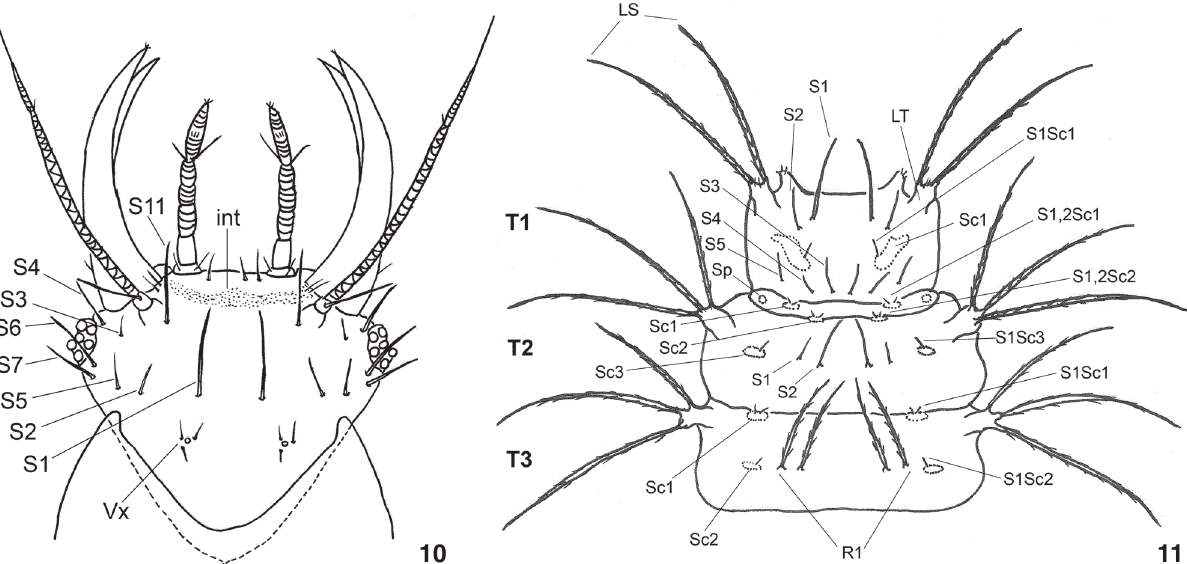
Figuras 10-11. Primeiro instar de C. caligata : (10) cabeça, vista dorsal; (11) tórax, vista dorsal. (int) Mancha intermandibular, (Sx) cerda primária, (Vx) três pequenas cerdas posteriores ao redor de um poro, (LS) cerda no tubérculo lateral, (LT) tubérculo lateral, (R1) fileira de cerdas, (Scx) esclerito, (Sp) espiráculo, (SxScx) cerda associada ao esclerito, (T1) protórax, (T2) mesotórax, (T3) metatórax.